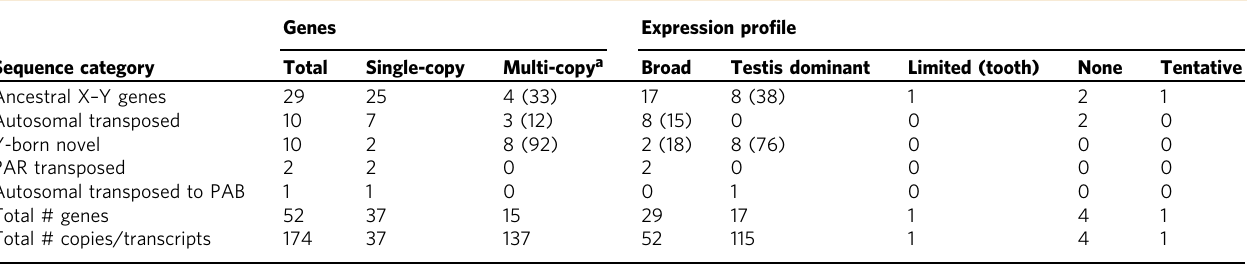
Table 1 Summary data for eMSY genes and